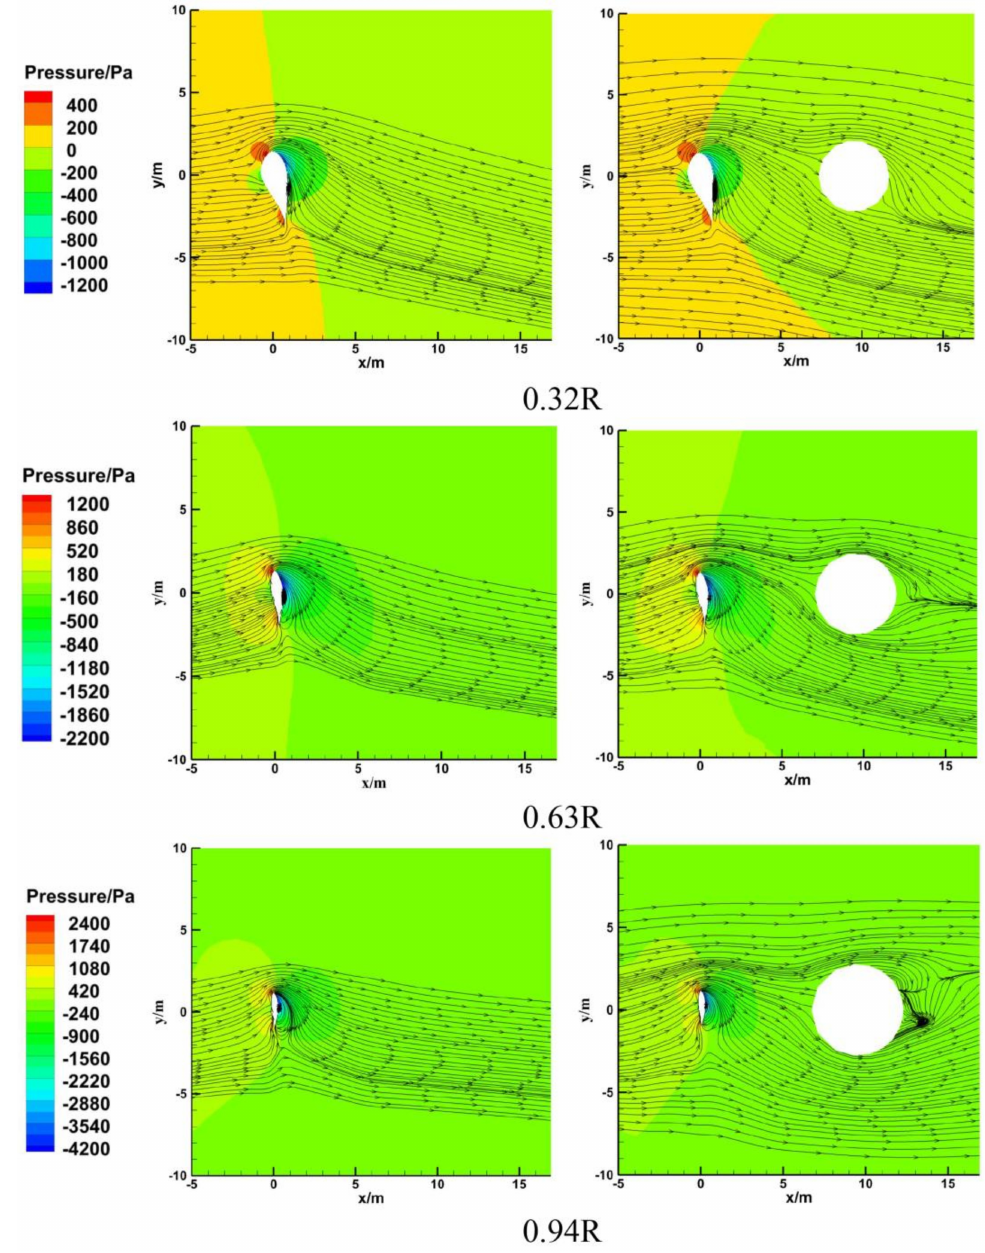
Figure 17. Streamline and pressure contours on different blade sections under pitch motion. Observing the streamline distribution shown in Figure 17, the main difference is still concentrated in the near wake flow field of the tower. It can be seen that the distribution of the streamline at 0.32 R section and 0.63 R section is similar under surge motion, but there is an obvious stall separation vortex under the pitch motion at 0.94 R section, because compared with the surge motion moving only in the horizontal direction, the pitch motion applies a relative partial velocity in the vertical direction to the wind turbine when the azimuth of the wind turbine changes. The angle between the direction of the incoming flow velocity and the rotating plane of the wind turbine is constantly changing, which makes the flow field more